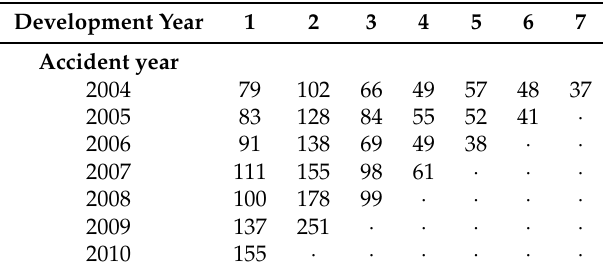
Table 2. Training incremental run-off triangle (in